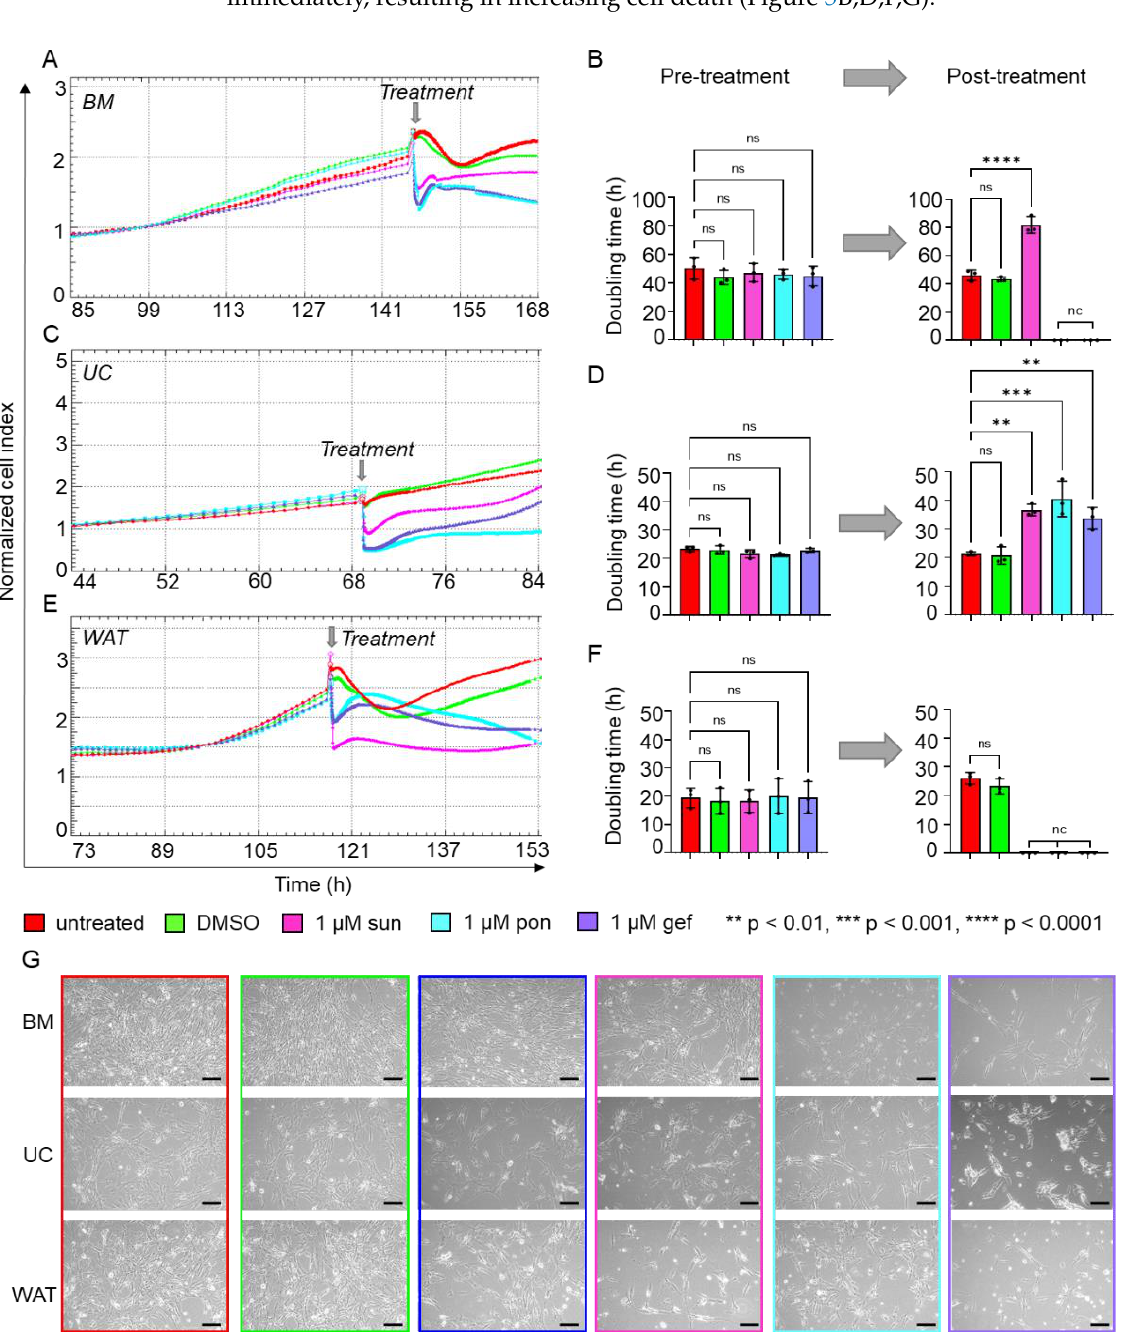
Figure 2. Inhibitors of TKR signaling significantly reduce HPL-induced proliferation. xCELLigence impedance measurements of ( A ) BM-, ( C ) UC- and ( E ) WAT-derived stromal cells before and after TKR inhibitor treatment. After reaching a normalized cell index of at least 2, treatment with either 1 µ M sunitinib (sun, magenta), 1 µ M ponatinib (pon, cyan) or 1 µ M gefitinib (gef, violet) was carried out (treatment time indicated as grey arrow). Untreated cells (red) or stromal cells treated with DMSO only (green) served as control. Our data reveal significantly reduced or completely abolished cell proliferation after TKR inhibitor treatment, as indicated. xCELLigence impedance measurements